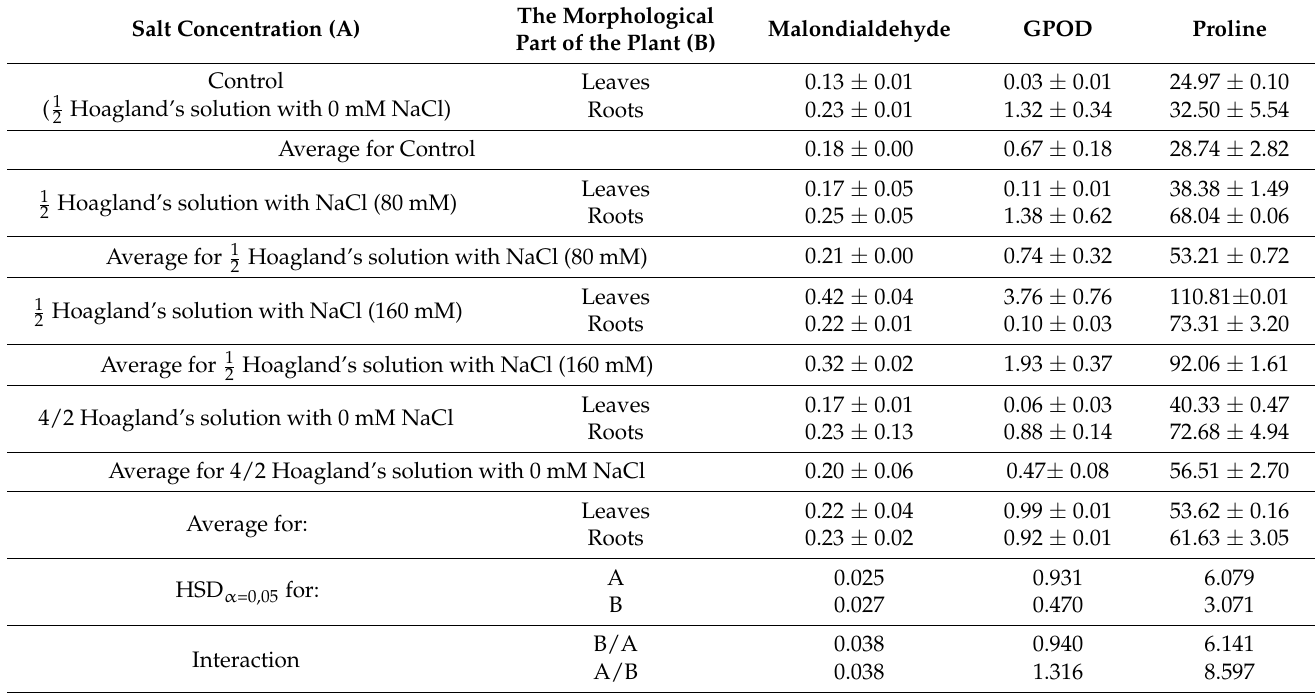
Table 1. The content of malondialdehyde (MDA (nmol MDA g − 1 FW)), guaiacol (GPOD (U g − 1 FW)), and proline (mg g − 1 FW) in leaves and roots of sweet basil exposed to